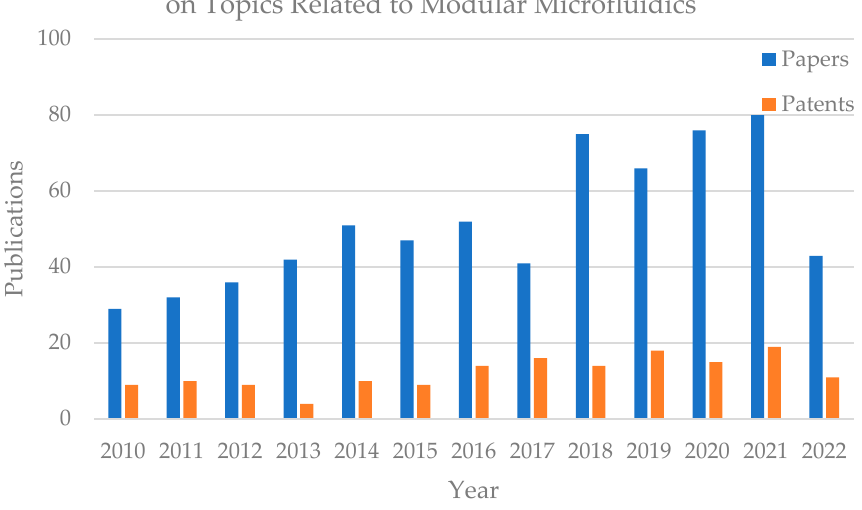
Figure 1. Annual publications on the topic of modular microfluidics. Paper search results were acquired from the Scopus Database, Elsevier with keywords ‘modular’ and ‘microfluidics’. Patent search results were acquired from the Patentscope database of the World Intellectual Property Organization (WIPO, Genève, Switzerland) using the search expression ‘FP (modular microfluidics)’.